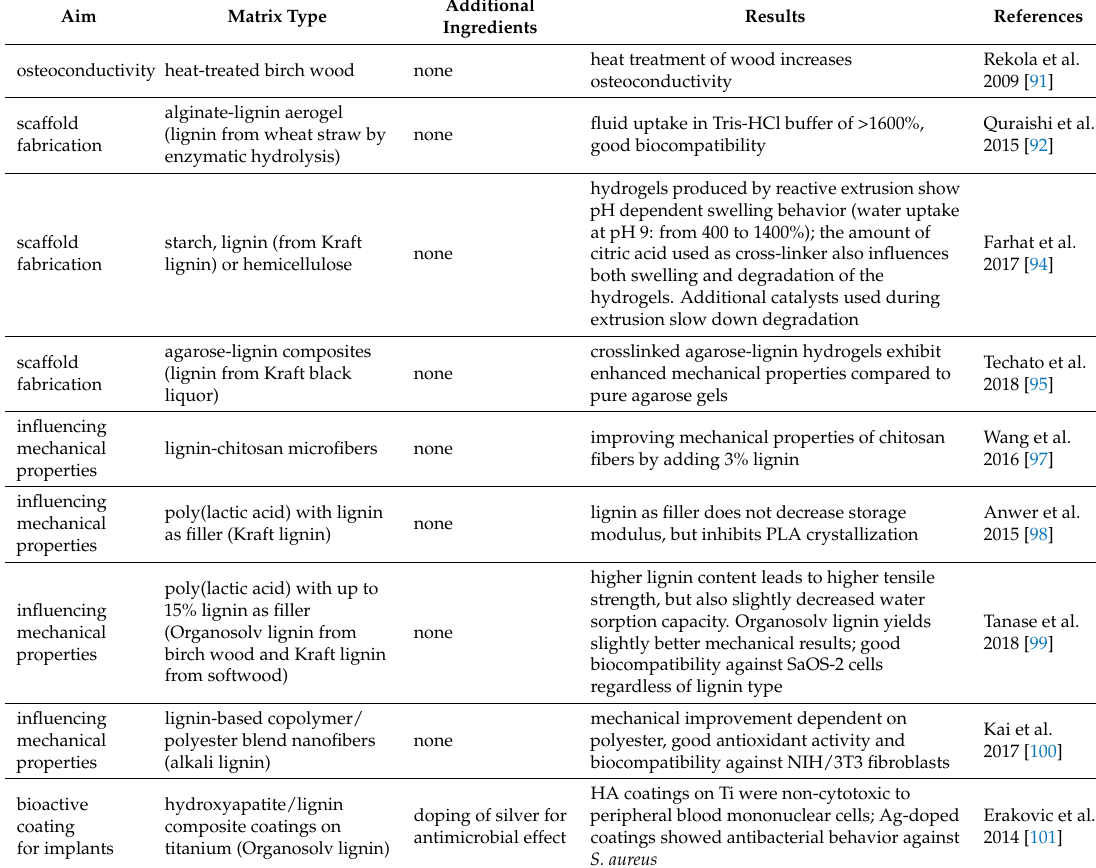
Table 4. Lignin-derived scaffold for possible bone tissue engineering